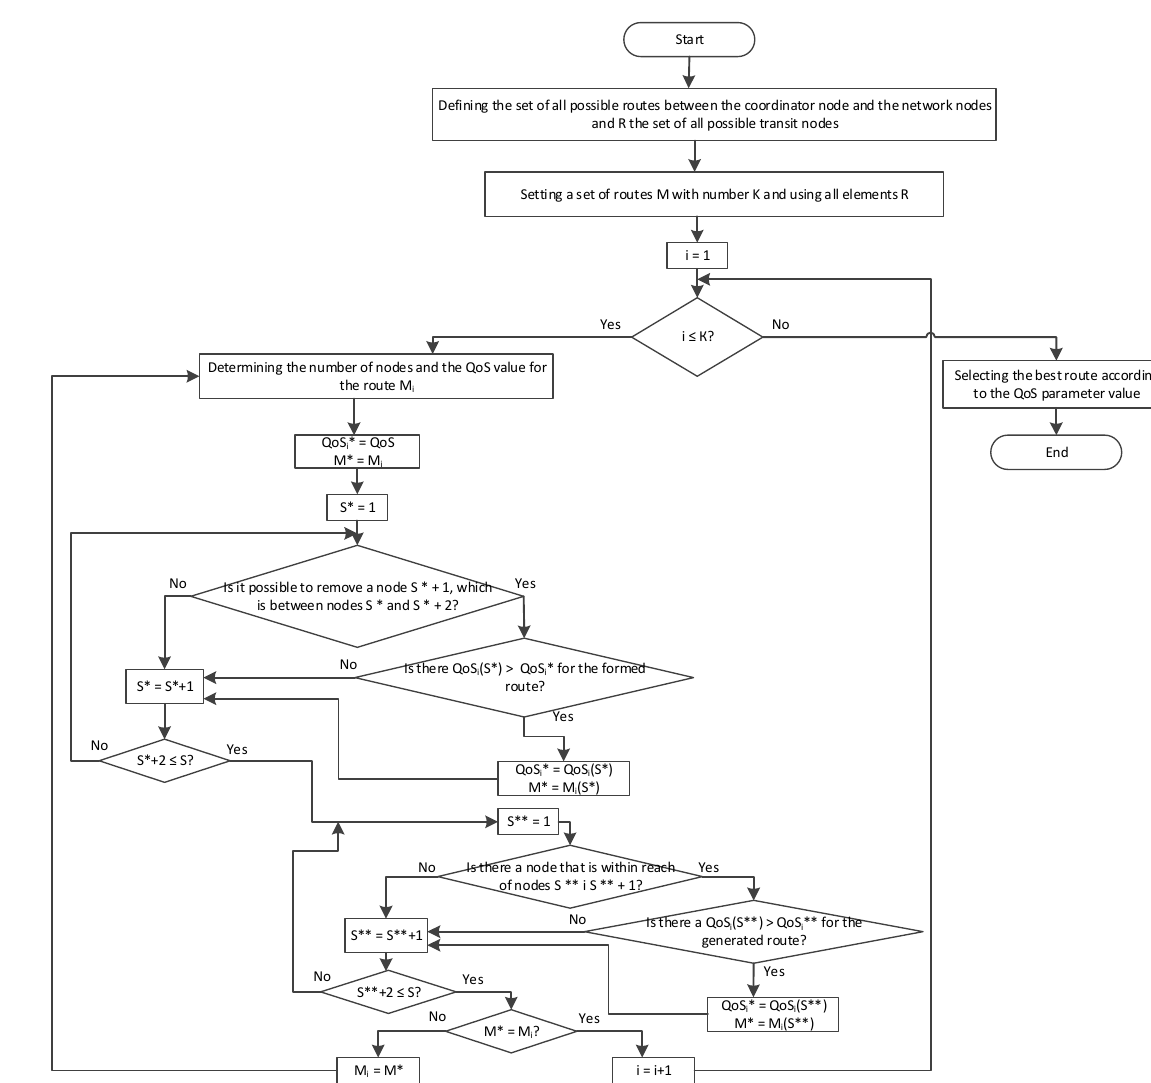
Figure 3. Block diagram of the developed simulated annealing Algorithm Algorithm 2. Simulated annealing algorithm (Figure 3)